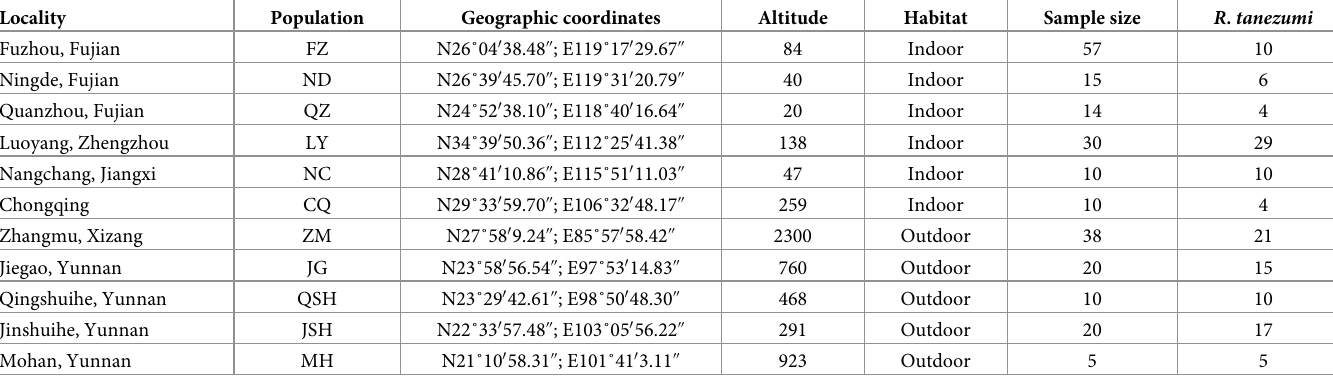
for 3 min; 35 cycles of 95˚C for 30 s, 50˚C ( Cytb )/55˚C (COI) for 30 s, and 72˚C for 90 s Table 1. Information on R . tanezumi samples used in the present